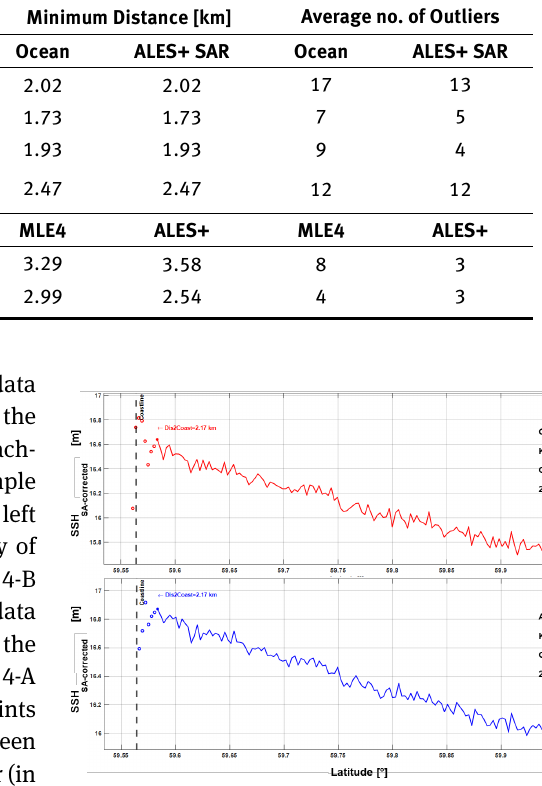
Figure 5: The along track SSH SA at Kunda station, pass #414 using Ocean (red) and ALES+ SAR (blue) retrackers and detected outliers (circles). Distance to the coast from first available good quality point is measured. The vertical dashed line denotes the location of coastline. The colored circles denote near-coast SSH SA